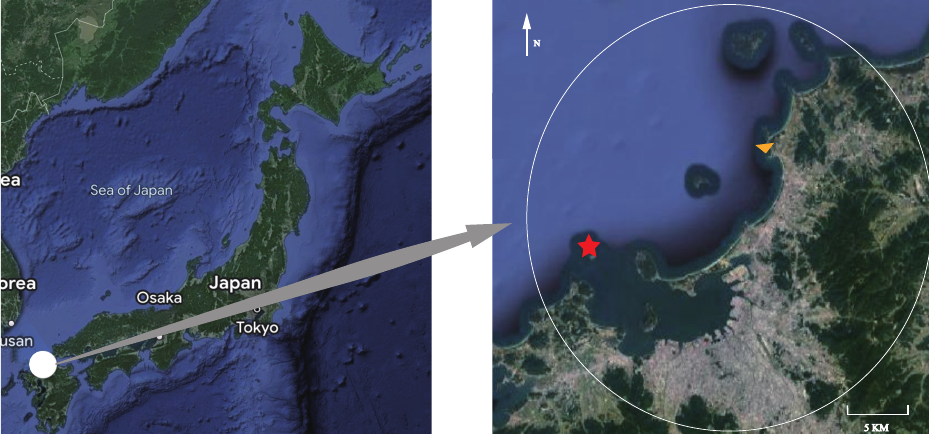
Figure 16. The data collection locations of two types of data. The yellow triangle and red star represents the locations that our measurement data and government data came from,